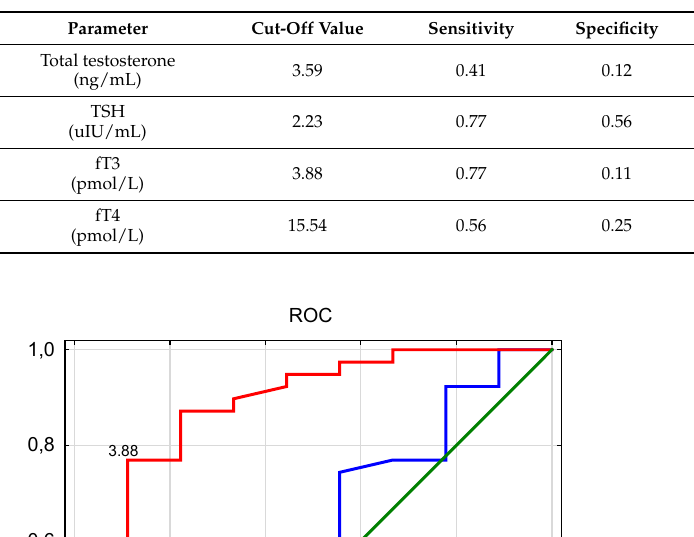
Table 4. ROC analysis of the selected hormone serum concentrations in the determination of prognosis in male dialysis patients.